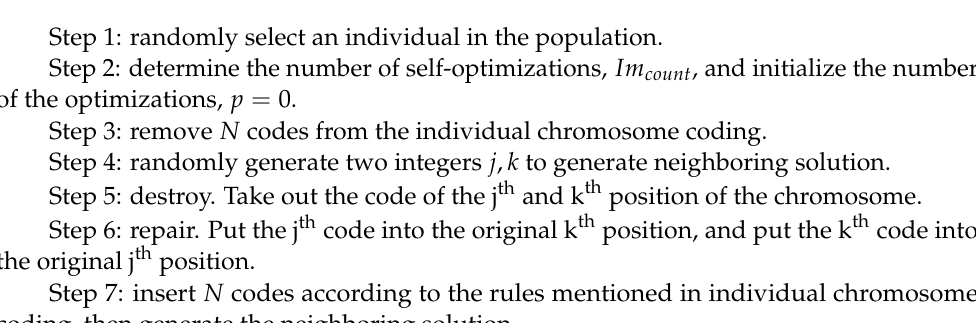
Figure 6. The schematic and the flowchart of self-optimization based on